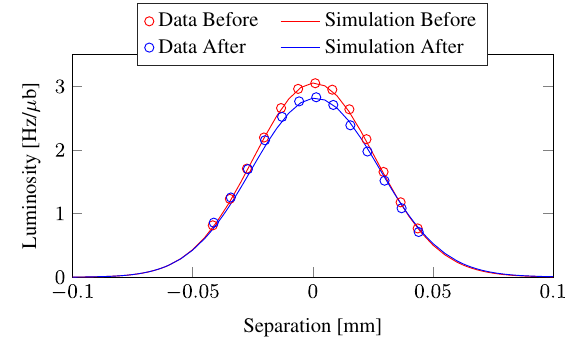
FIG. 7. The scan data and the simulation based on the measured profiles. The effects of the bunch profile change are well reproduced. The transverse emittances of the two simulated scans are